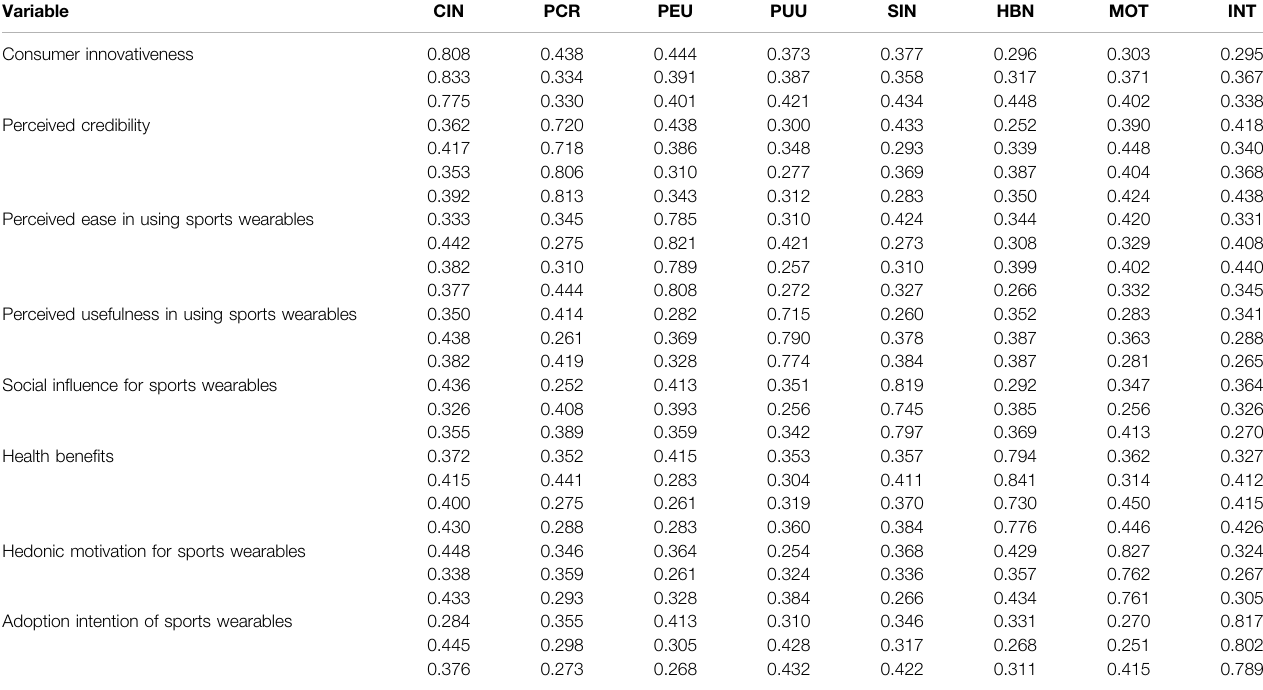
TABLE 4 | Results of loadings and cross loadings.